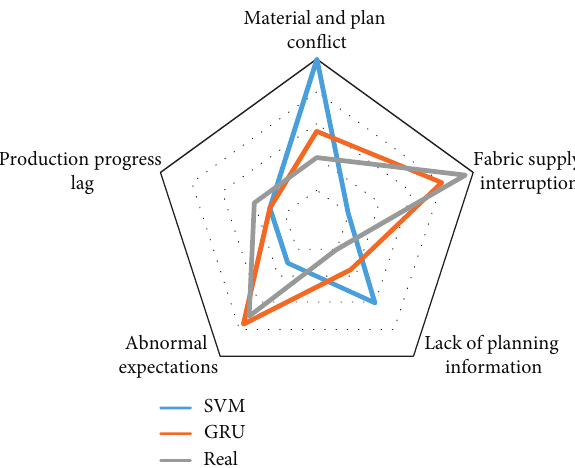
Figure 8: Enterprise operation risk prediction compared with SVM